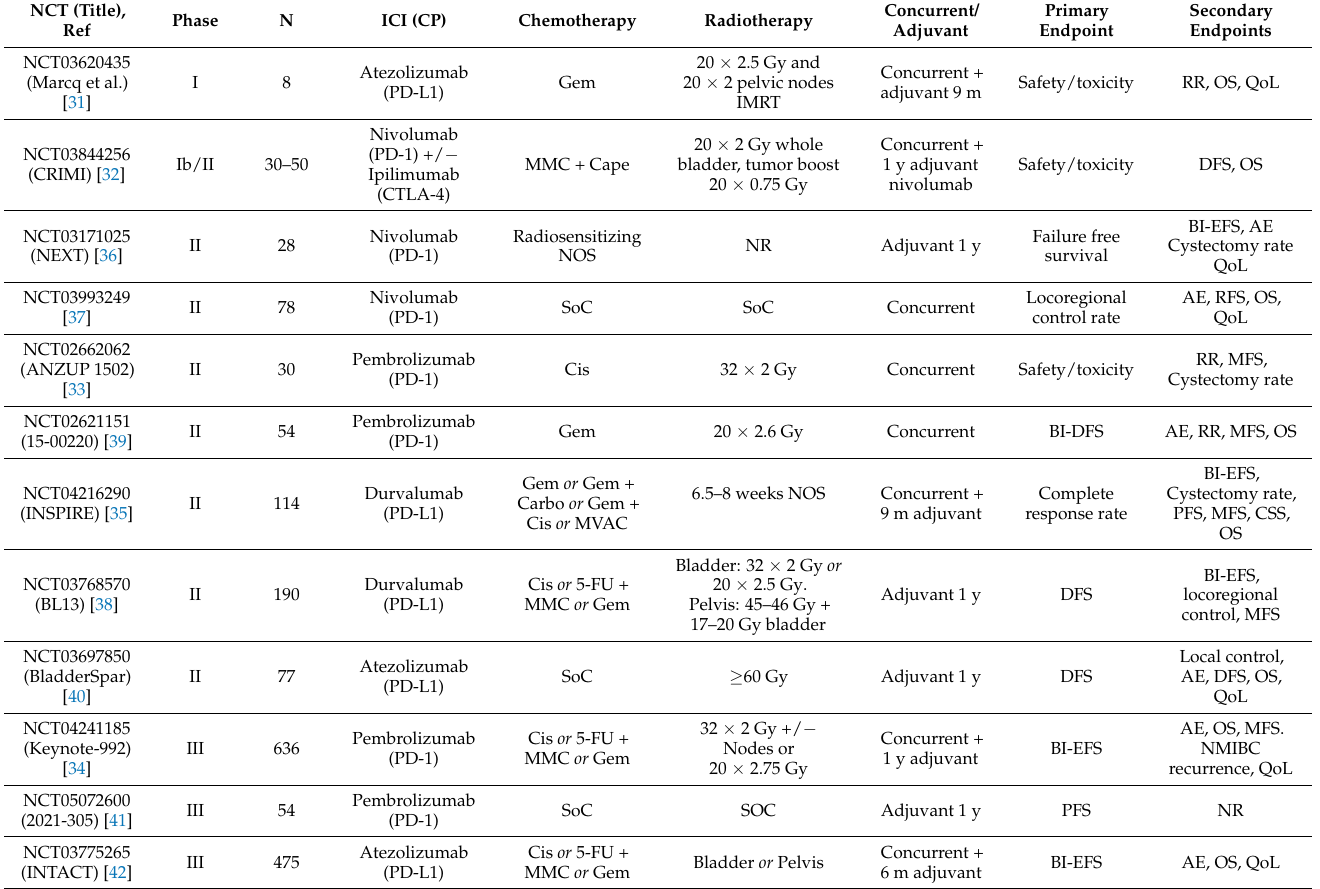
Table 1. General overview of currently enrolling